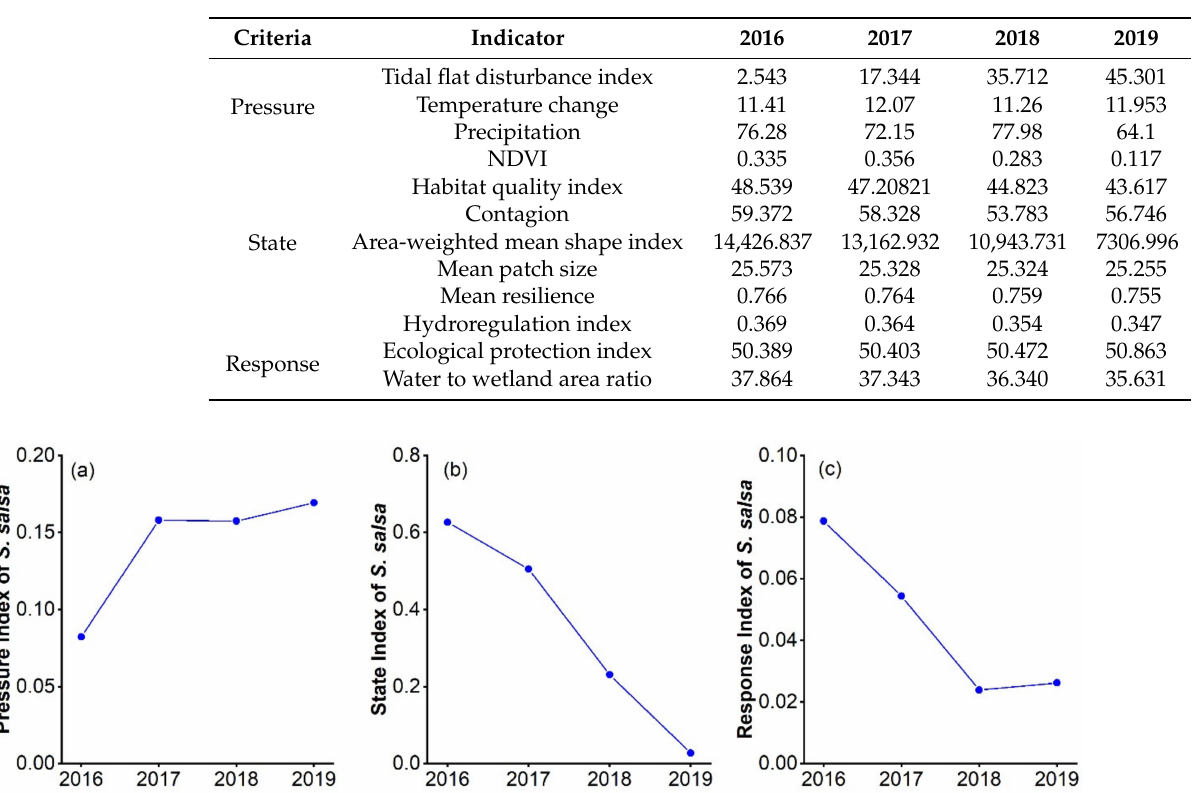
Figure 4. ( a ) pressure indicators, ( b ) state indicators and ( c ) response indicators for the PSR model from 2016 to